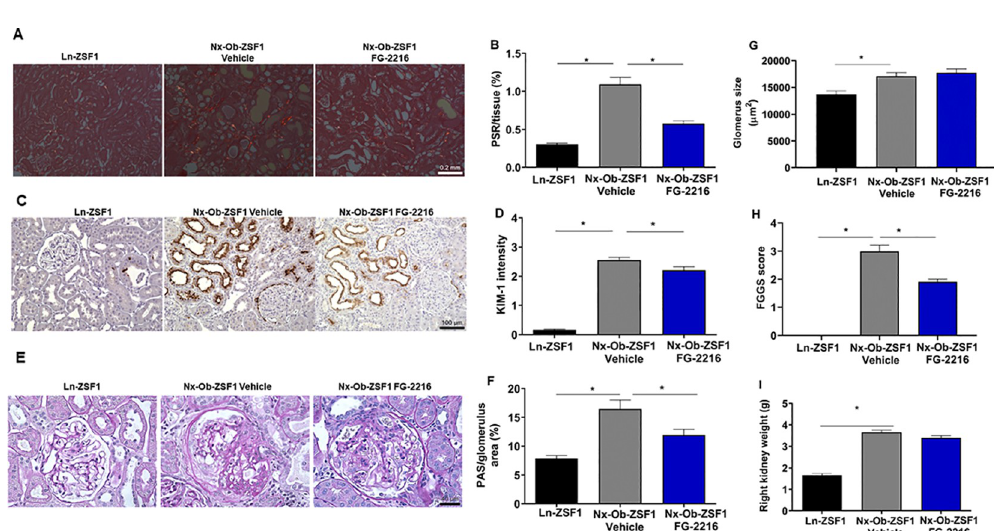
Fig 4. FG-2216 improved kidney morphology in Nx-Ob-ZSF1 rats. Kidneys were harvested after 18 weeks of treatment and sectioned for histology. Picrosirius red (PSR) staining of fibrillar collagen showed tubular interstitial fibrosis ( A ). FG- 2216 reduced PSR staining ( B ). Immunohistochemistry for Kidney Injury Molecule-1 (KIM-1) indicated tubular damage ( C ). FG-2216 decreased KIM-1 signal intensity ( D ). Periodic acid-Schiff (PAS) staining showed mesangial expansion in the glomerulus ( E ). FG-2216 reduced fractional mesangial expansion ( F ) without affecting glomerulus tuft area ( G ). Glomerulosclerosis quantified on sections stained with methenamine silver-trichrome showed less focal global glomerulosclerosis (FGGS) in Nx-Ob-ZSF1 FG-2216 animals than in Nx-Ob-ZSF1 Vehicle animals ( H ). The right kidney increased in mass in the Nx-Ob-ZSF1 animals to compensate for nephrectomy of the left kidney ( I ). Values represent mean ± SEM (n = 8–12). � P < 0.05 vs . Nx-Ob-ZSF1 Vehicle (Dunnett’s test).